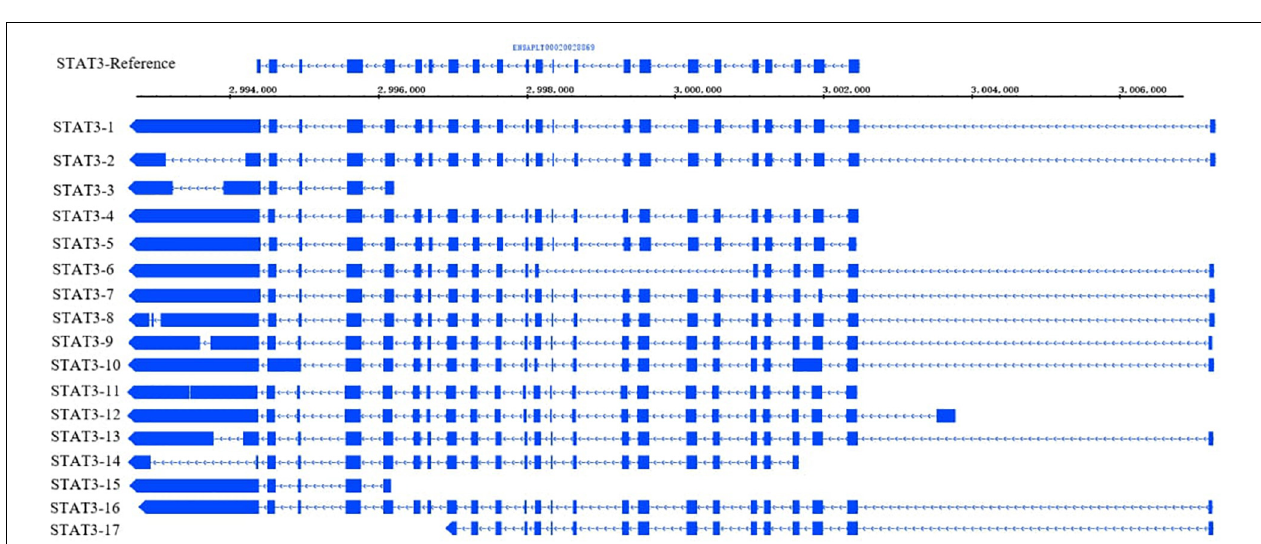
FIGURE 7 | Histogram of the number of different expression transcript (DET) in different tissues at different time of abdominal and subcutaneous adipose.